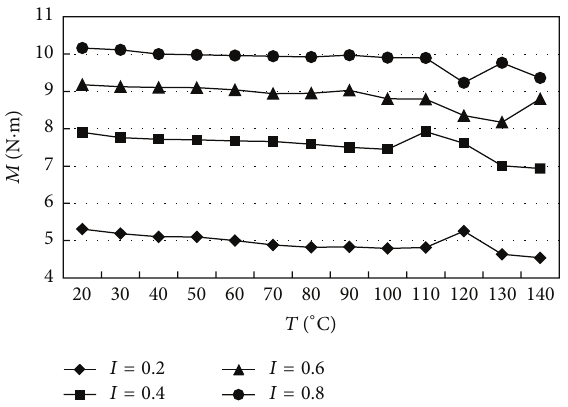
Figure 7: The curve of torque versus